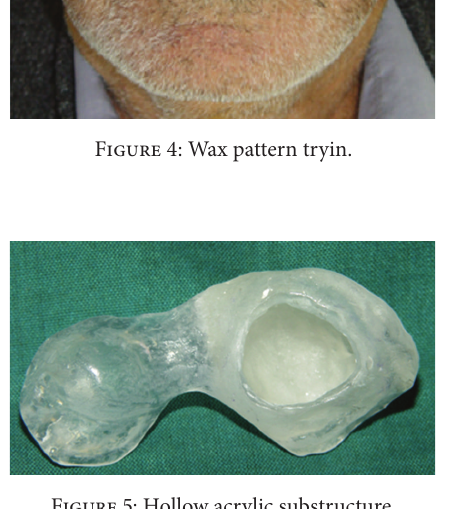
Figure 6: Attached intra and extraoral prostheses.